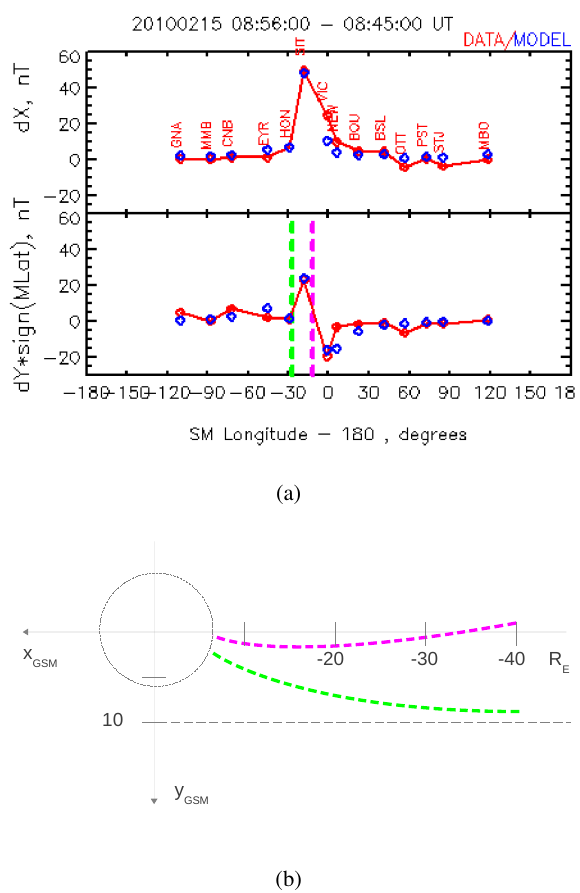
Fig. 5. The criterion of | B |≈ 0 is used to mark out the dis- 26 turbance signature, which is indicated by black vertical lines in Fig. 5.